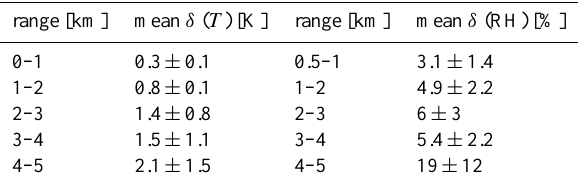
Table 3. Mean absolute deviation (mean δ ) for temperature and rel- ative humidity profiles for the six experiments at different altitude ranges.